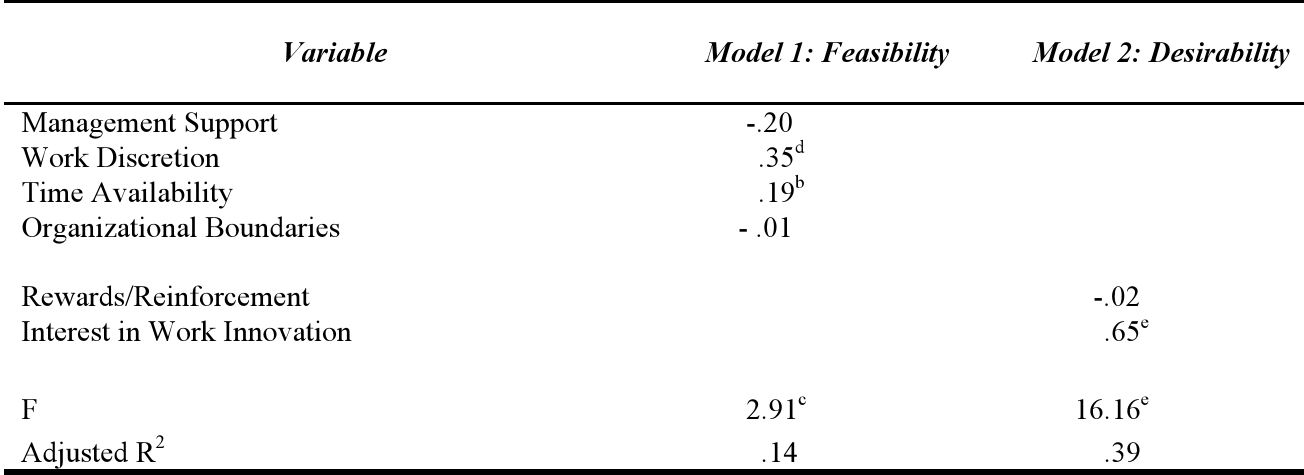
Table 3. Results of Regression Analysis for Feasibility and Desirability